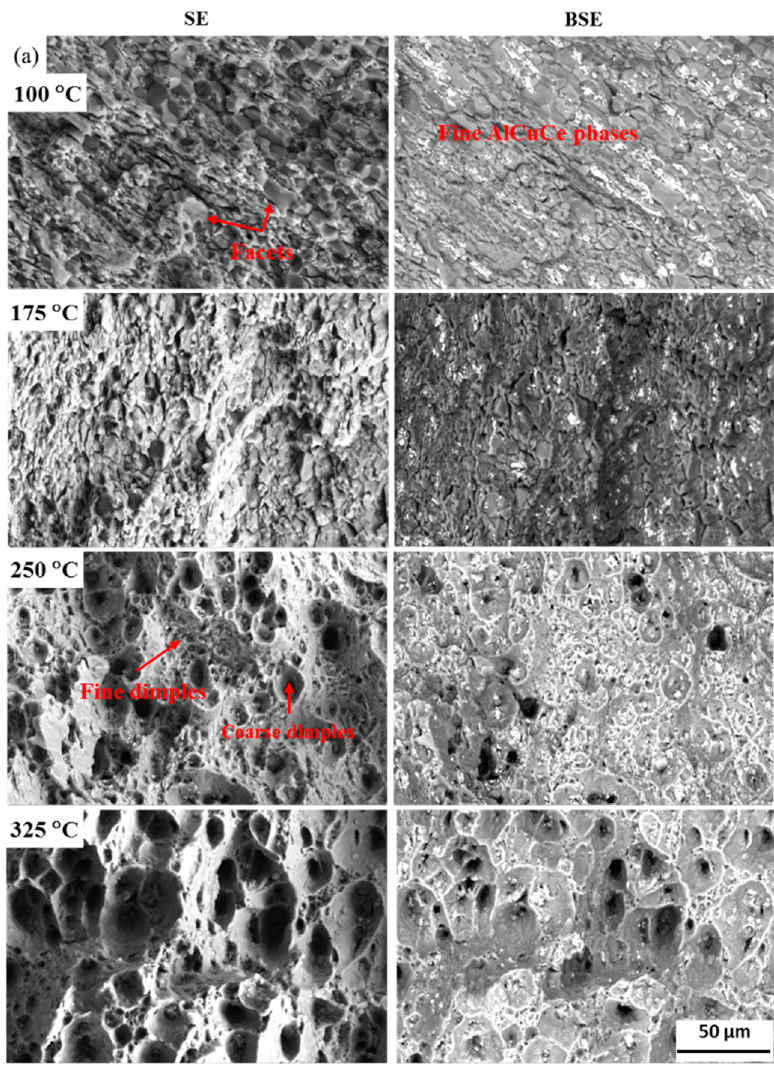
Figure 10; Figure 11. The cleavage facets, which indicate